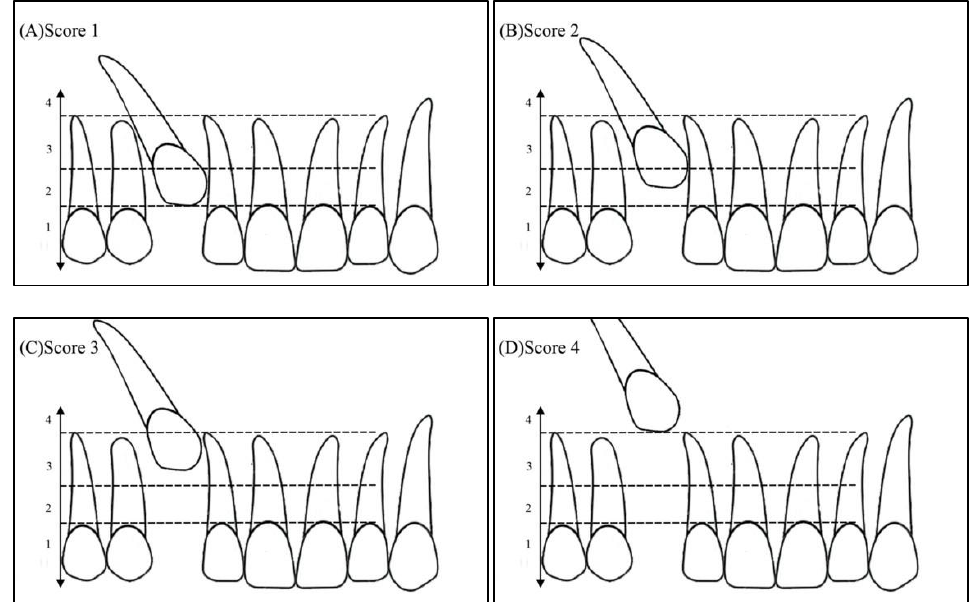
Figure 4. Vertical position of the impacted canine: ( A ) Score 1—canine cusp tip at the level of the cementoenamel junction of the adjacent incisor, ( B ) Score 2—canine cusp tip at the middle of the root of the adjacent incisor, ( C ) Score 3—canine cusp tip within the apical third of the root of the adjacent incisor, ( D ) Score 4—canine cusp tip above the apical third of the root of the adjacent incisor.